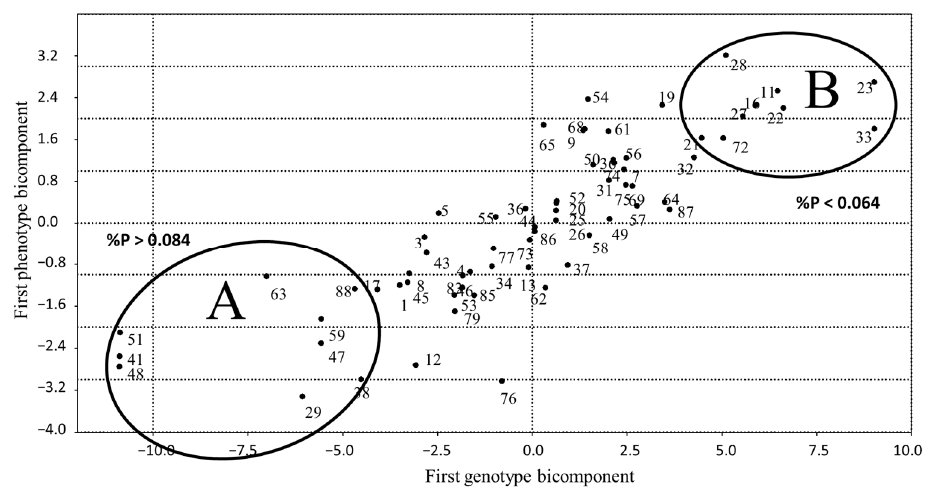
Figure 4. Correlation of phenotype and genotype bicomponents. Ovals encircle 10% quantiles from both sides of the cloud, related to the most promising varieties for breeding. Oval A includes nine varieties (29, 38, 41, 47, 48, 51, 59, 63, 88) with phosphorus content in starch >0.084%. Oval B includes nine varieties (11, 16, 21, 22, 23, 27, 28, 33, 72) with phosphorus content in starch <0.064%.